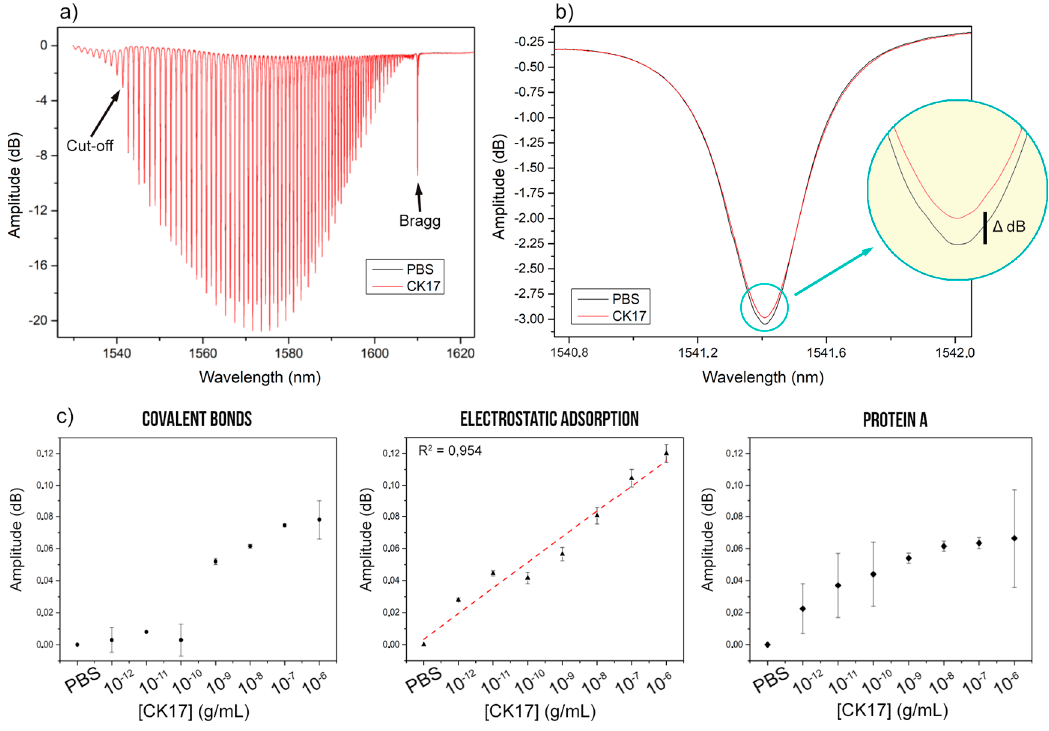
Figure 3. Near-IR spectra of one bare-TFBG functionalized with anti-CK17 antibodies, immersed into PBS and 10 − 6 CK17 solution, successively. ( a ) The first cut-off mode shows the most intense shift after immersion into CK17 solution. ( b ) After that, each functionalization process was tested for biosensing in growing CK17 concentration from 10 − 12 to 10 − 6 g/mL. Graphs show experimental results obtained in triplicates for each condition, using different sensors (mean ± standard deviation) with a linear fitting (red dotted line) for condition B ( c ).